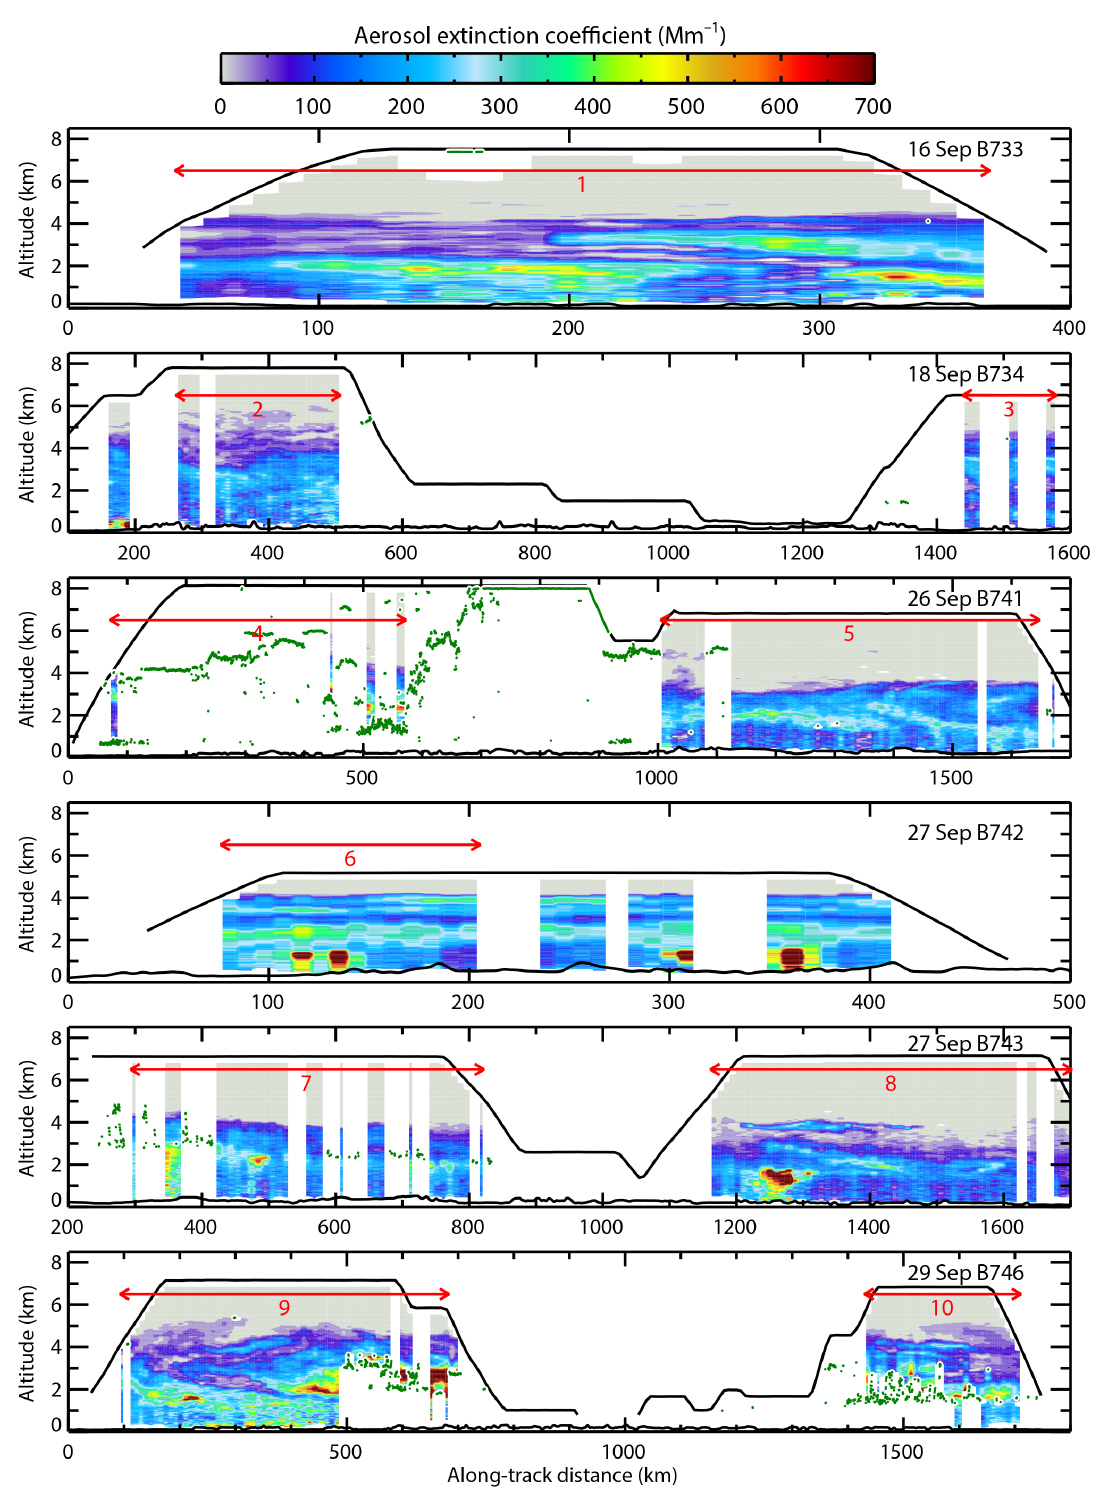
Figure 5. Cross-sections of the aerosol extinction coefficient determined from the lidar for the six research flights with a 1-min integration time. The black lines indicate the aircraft altitude and the surface elevation from a digital elevation model, respectively. The green dots indicate cloud tops detected with the lidar at 2s resolution. The red numbered arrows indicate the selected sections for the characterisation of the aerosol layer (see Table